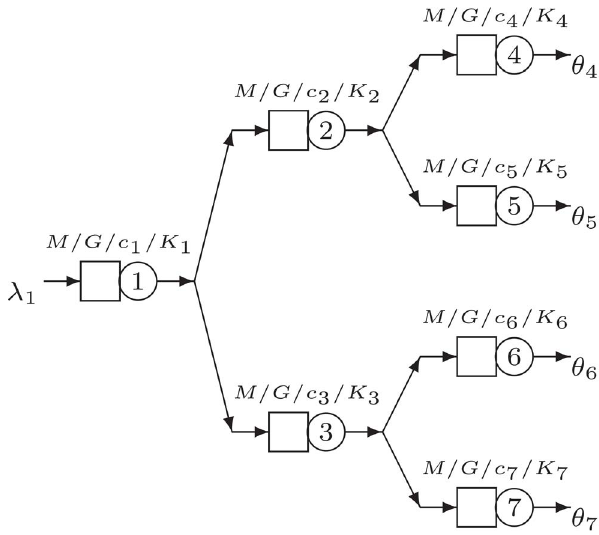
Figure 6. Network structure C1.